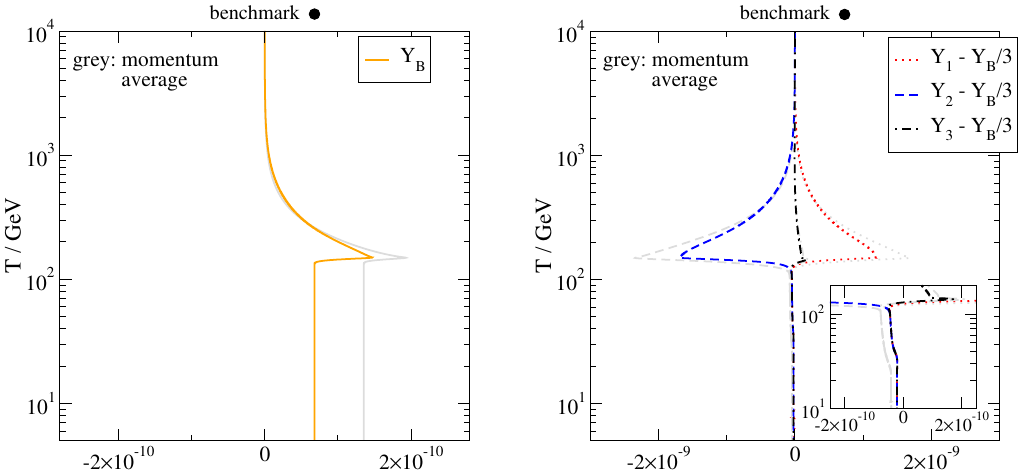
Figure 2 . Left: baryon yield as a function of T= GeV for the benchmark point de(cid:12)ned in section 8. Grey lines show the outcome if we resort to momentum averaging, like in (cid:12)gure 1.